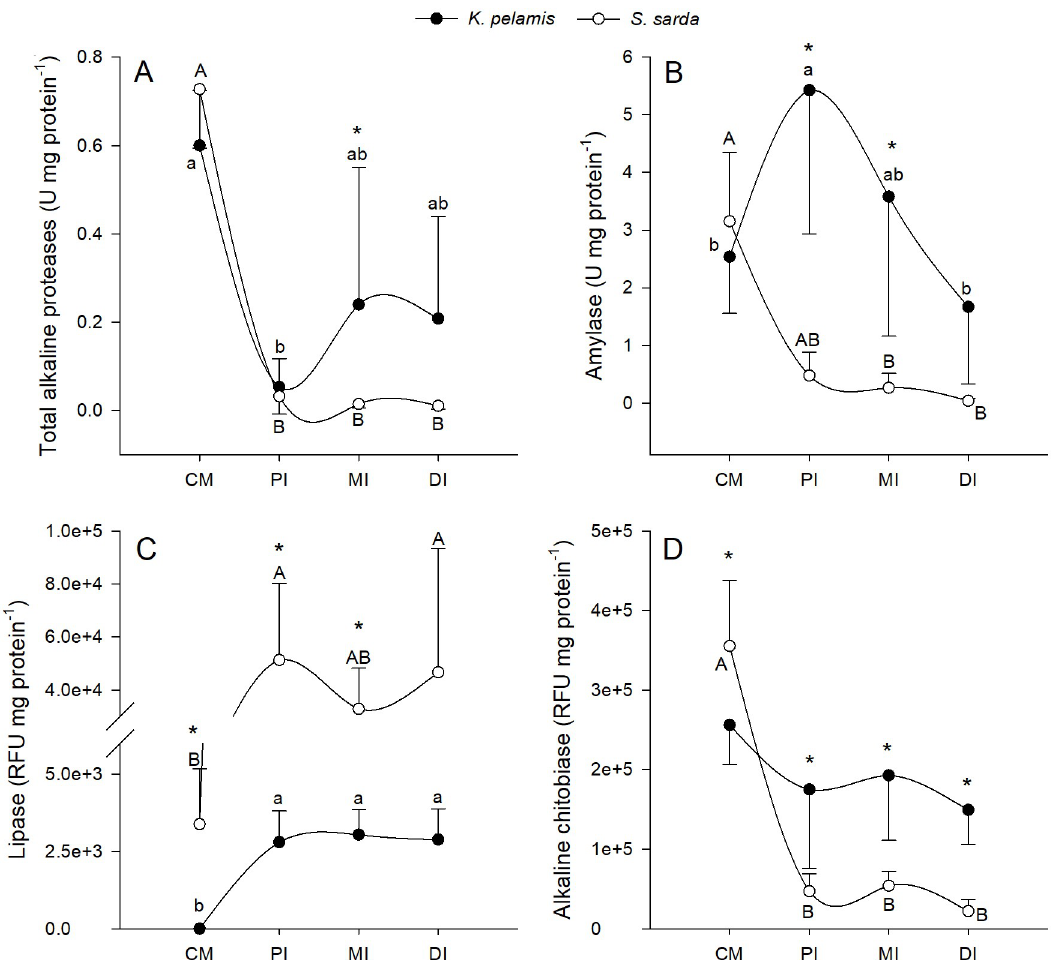
Fig 5. Alkaline digestive enzymes activity levels. Total alkaline proteases (A), amylase (B), lipase (C) and alkaline chitobiase (D) activities in Katsuwonus pelamis (black dots) and Sarda sarda (white dots). Data are presented as mean ± SD ( n = 10, n = 5 for distal intestine of K . pelamis ). Different lowercase letters (a,b) represent statistical differences between digestive organs of S . sarda , while different capital letters (A, B) represent statistical differences between digestive organs of K . pelamis (P < 0.05). Asterisks represent statistical differences between species (P < 0.05). Absence of asterisk indicates no statistical difference between species (P >